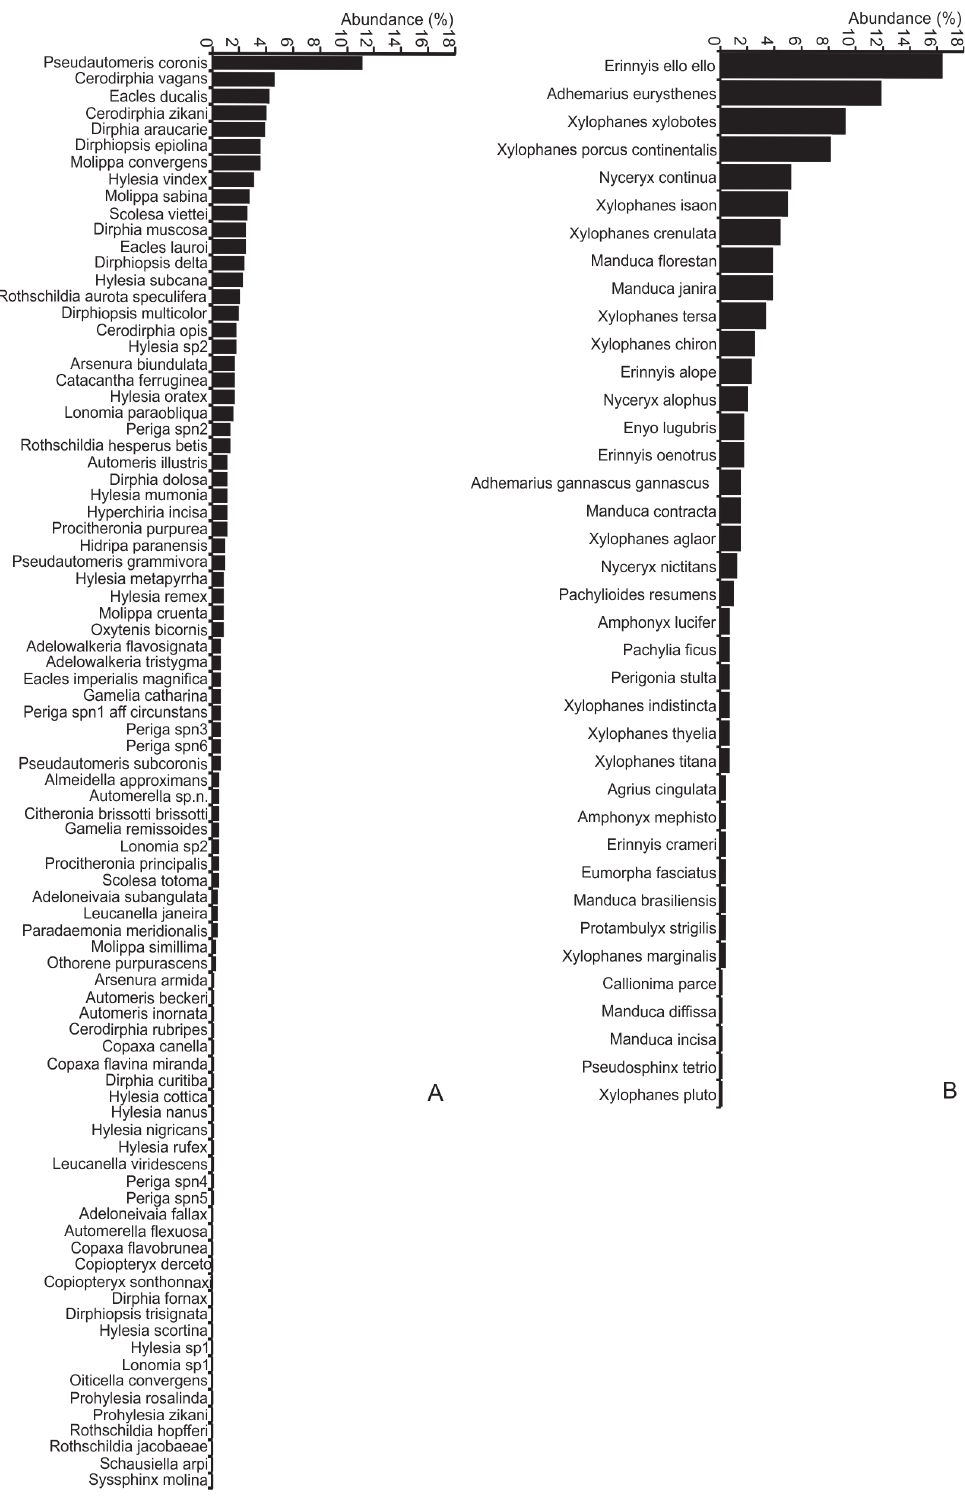
Figure 1 - Curve of the dominance component being represented by the relative abundance of species caught: Saturniidae (A) and Sphingidae (B)